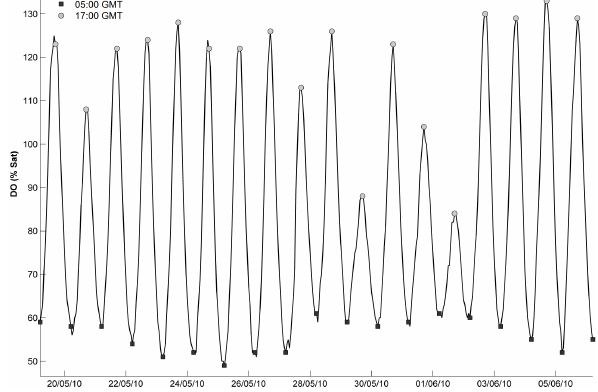
1 Figure 10 2 Fig. 10. Diurnal cycling observed within The Cut dissolved oxy- gen time series, with peak saturation levels in the late afternoon, 17:00:00GMT, and minimum saturation in the early morning,